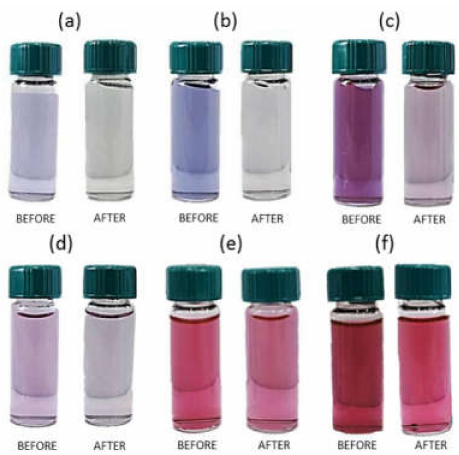
Figure 6. Colloidal gold obtained during reduction reaction of Au(III) ions with reductant. Exper- imental conditions: C 0, Au(III) = 0.05 mM, C 0, H2Asc = 0.9 mM ( a ); C 0, Au(III) = 0.15 mM, C 0, H2Asc = 0.9 mM ( b ); C 0, Au(III) = 0.3 mM, C 0, H2Asc = 0.9 mM ( c ), all colloids are without PVA. C 0, Au(III)